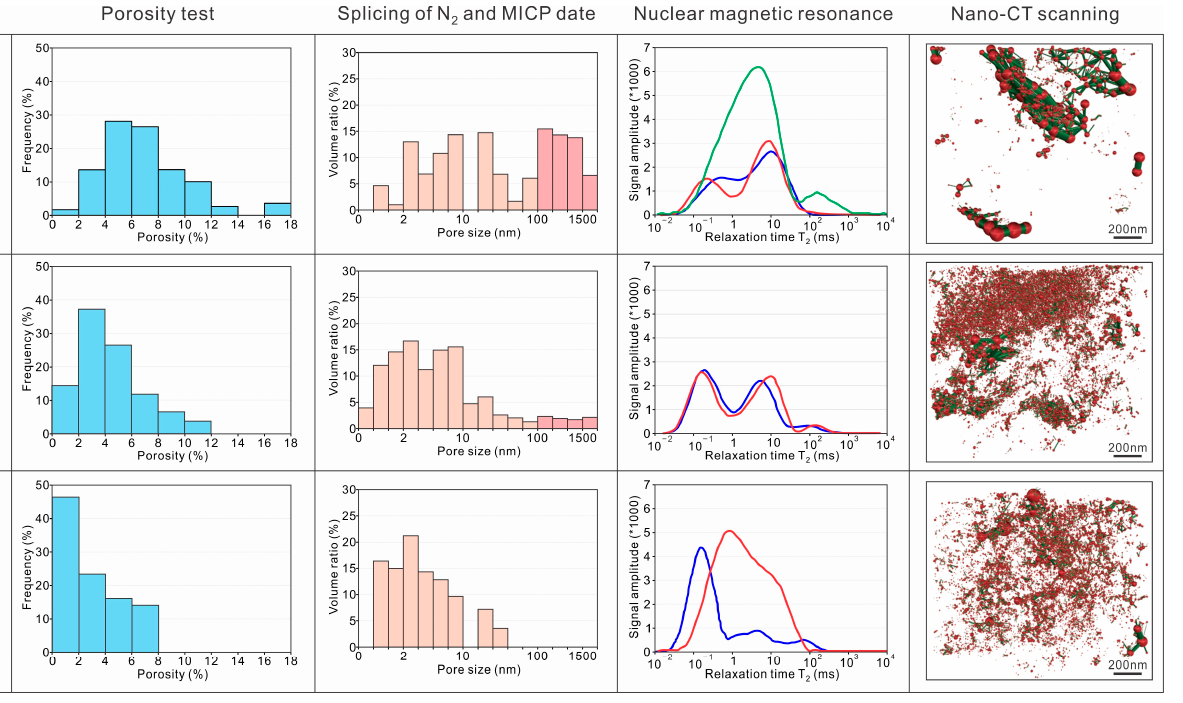
Figure 5. Distribution characteristics of porosity, pore size, NMR, and Nano-CT scanning for different types of shale. Date from [29,44,75,76,111,115,116].